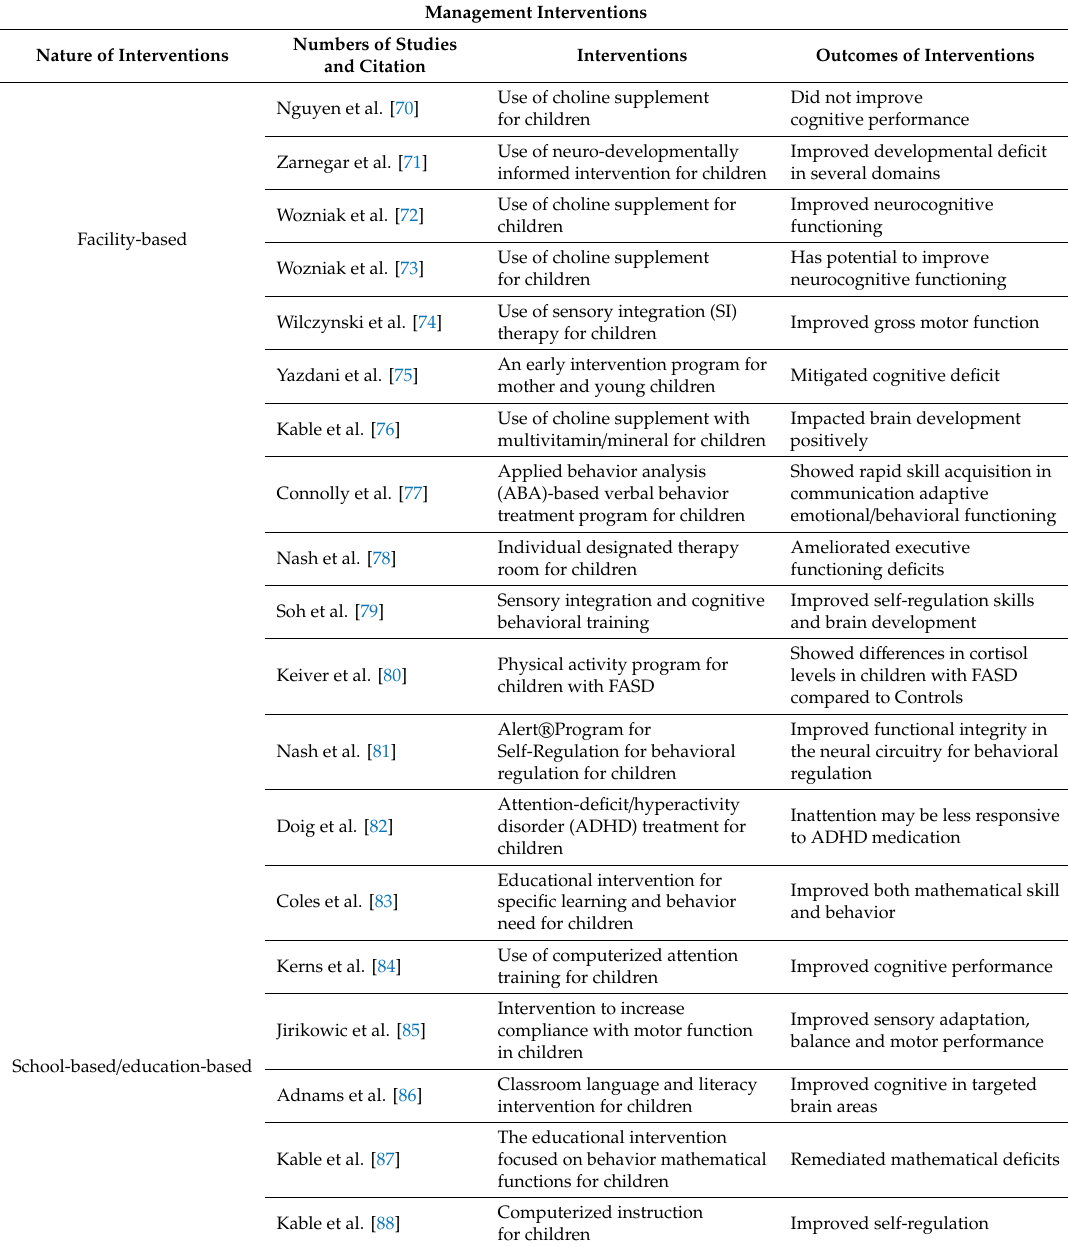
Table 5. Themes generated from the management